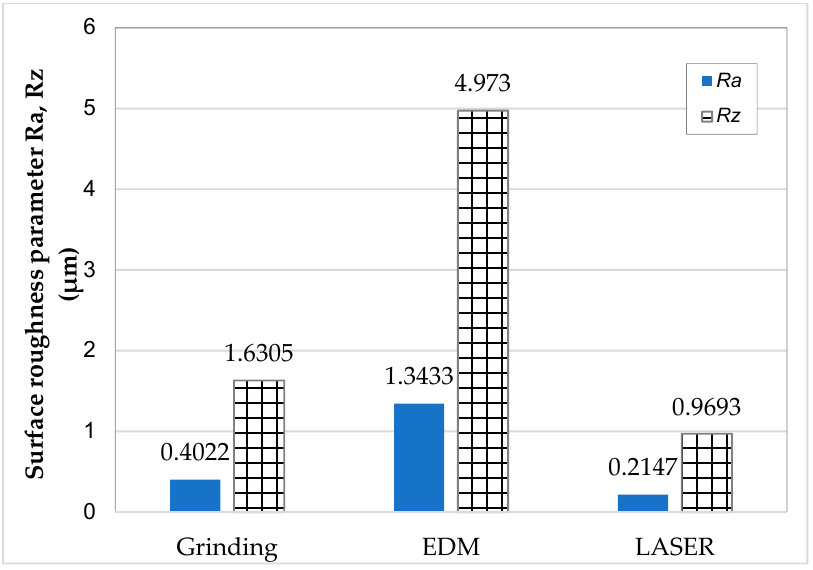
Figure 11. Comparison of values of surface roughness parameters Ra and Rz on a cutting insert.